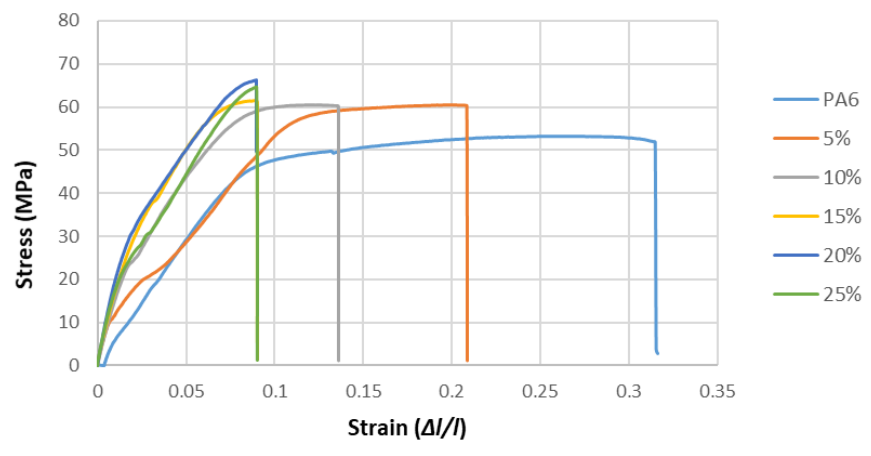
Figure 9. Stress-strain curves of neat PA6 and cellulose pulp-PA6 composites.